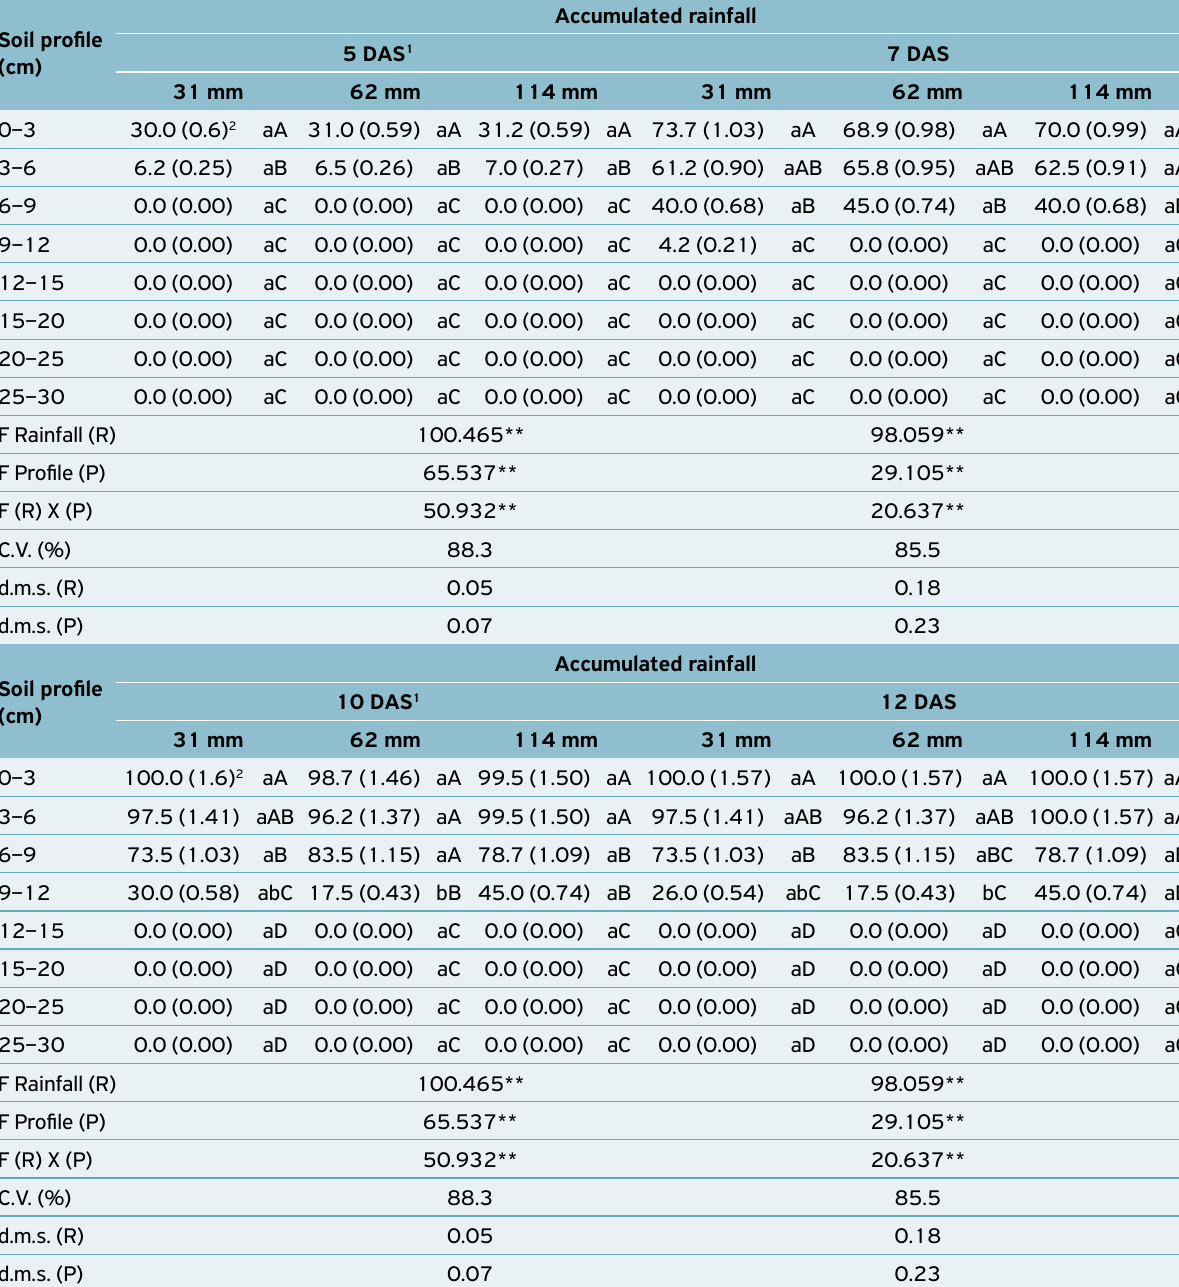
Table 4. Phytotoxicity percentage in lettuce plants after the application of tebuthiuron to a clayish-textured soil under different rainfall amounts. Botucatu, São Paulo,